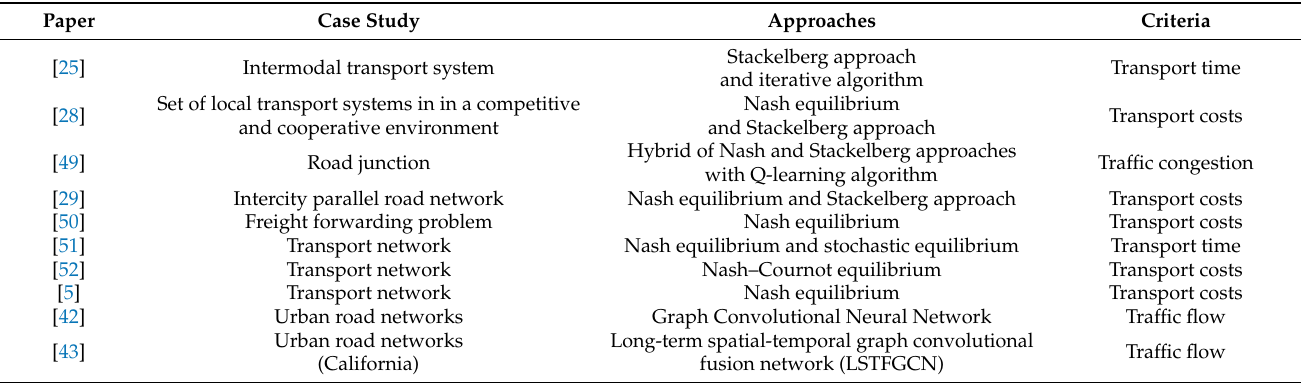
Table 1. Overview of publications on transport system modelling and